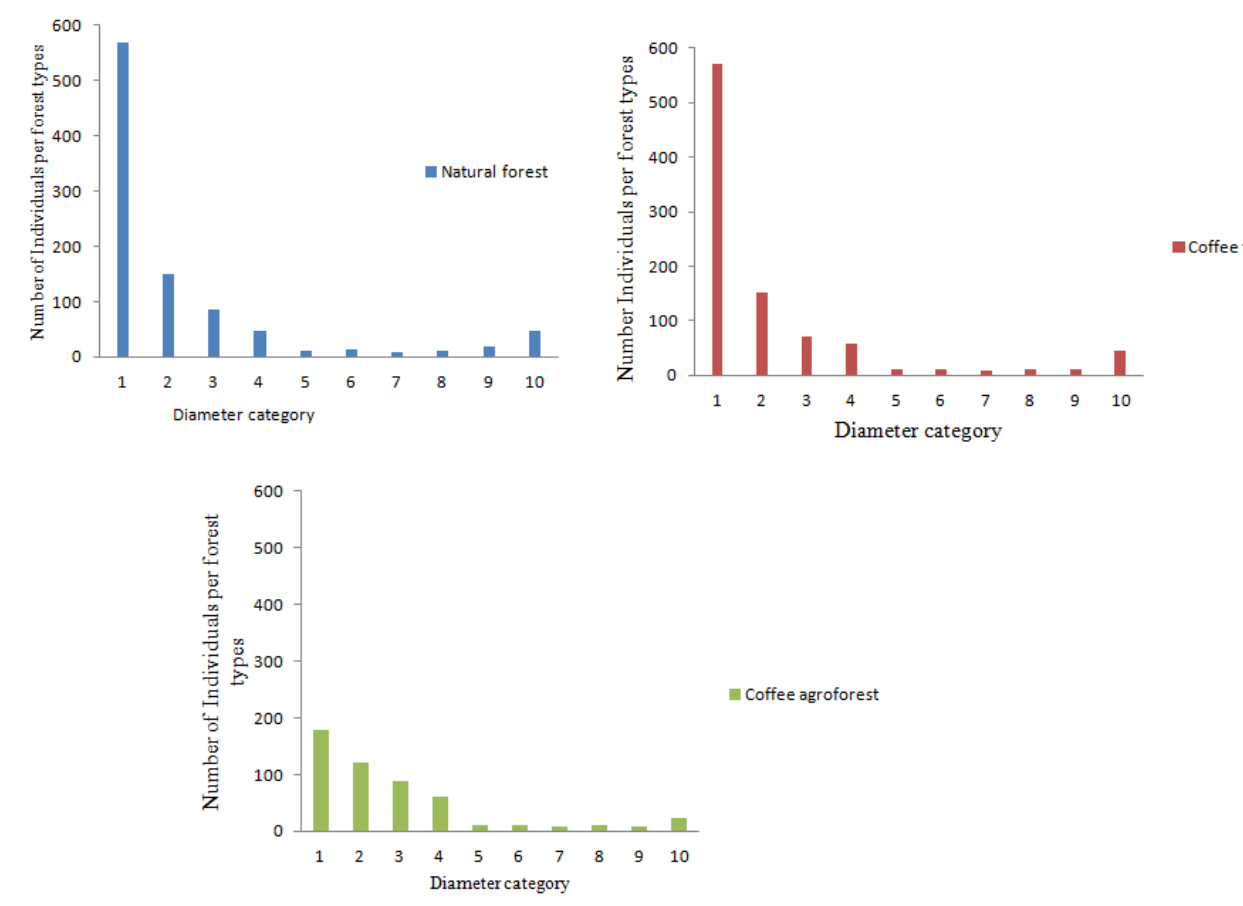
Figure 6. Diameter categories of woody species in the natural forest, coffee forest and agroforest. 1 = 10–20 cm 2 = 21–30 cm 3 = 31–40 cm 4 = 41–50 cm 5 = 51–60 cm 6 = 61–70 cm 7 = 71–80 cm 8 = 81–90 cm. 9 = 91–100 cm 10= >100 cm. Table 5. Total number of individuals and basal area in 2.52 ha (63 plots) of the three forest types. Natural Forest Coffee Forest Coffee Agroforest p -Value